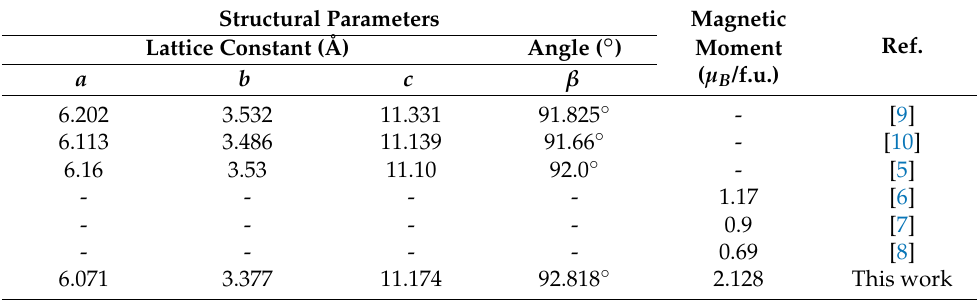
Table 1. Structural and magnetic parameters of monoclinic phase of Fe 3 Se 4 .